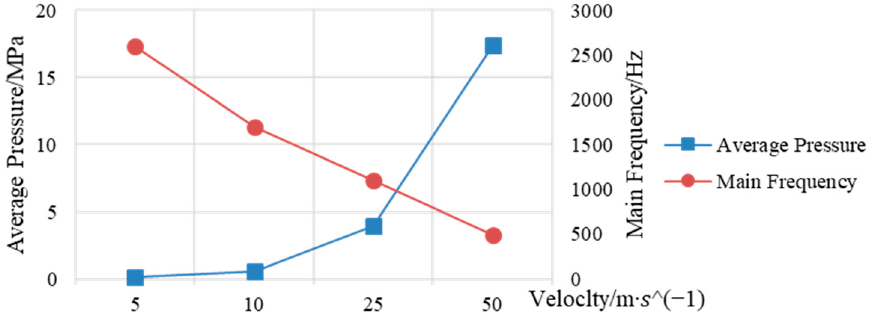
Figure 23. Pressure and main frequency of the servo valve flapper at different speeds.